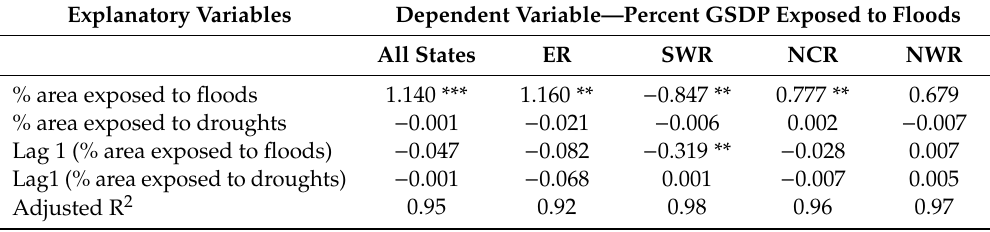
Table 3. Statistical significance of the relationship of flood exposed areas and GSDP. Explanatory Variables